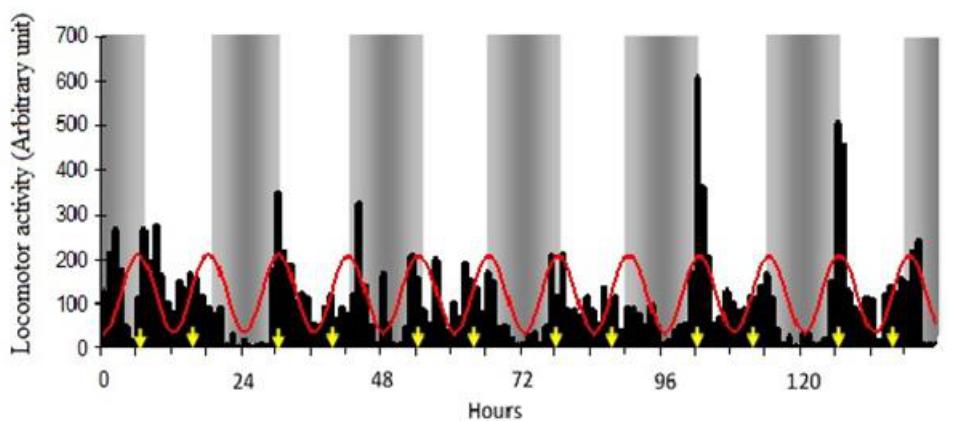
Figure 2. Rhythms of the resting activity of Holstein calves (bars) and curve obtained by applying the cosenoidal adjustment model to the variable under study (continuous line). The gray area indicates hours of darkness; yellow arrow indicates the time of food intake. Table 1. Circadian rhythm parameters (mesor, amplitude, acrophase, and robustness of rhythm) recorded during six days of monitoring in eight Holstein calves of 30 days of life, expressed as mean ± sd in their conventional unit.